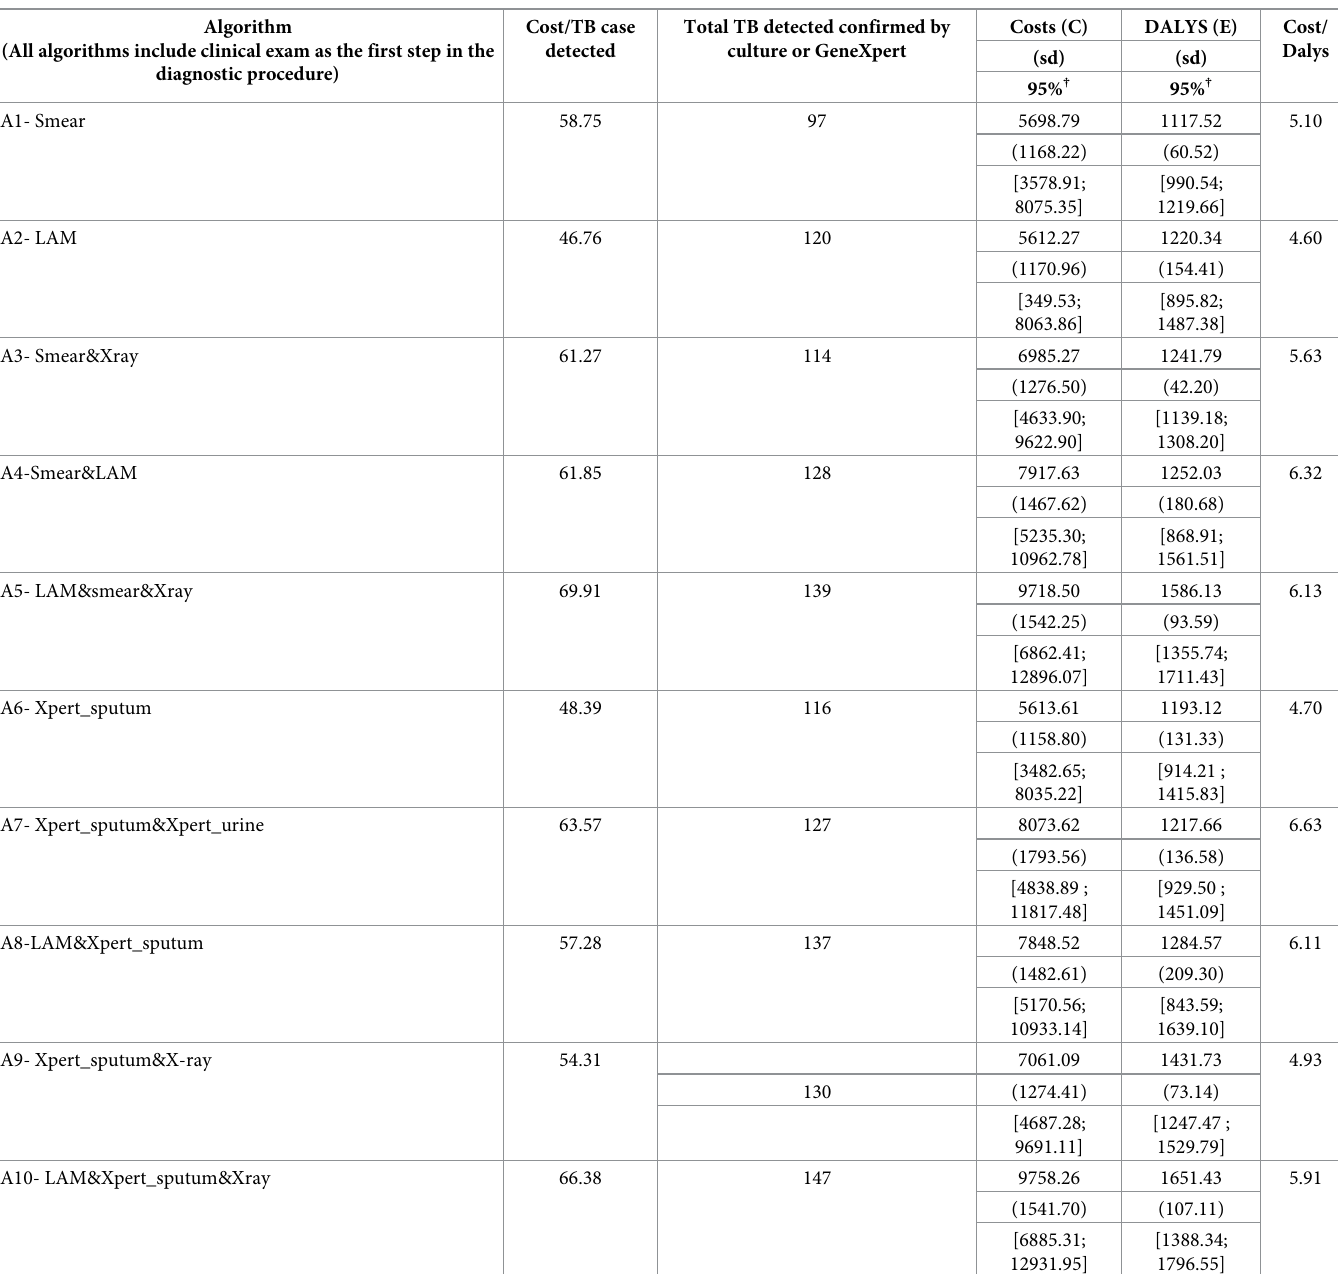
Table 3. Total cost and total DALYs averted (in euros, 4% discount, N = 275). Algorithm (All algorithms include clinical exam as the first step in the diagnostic